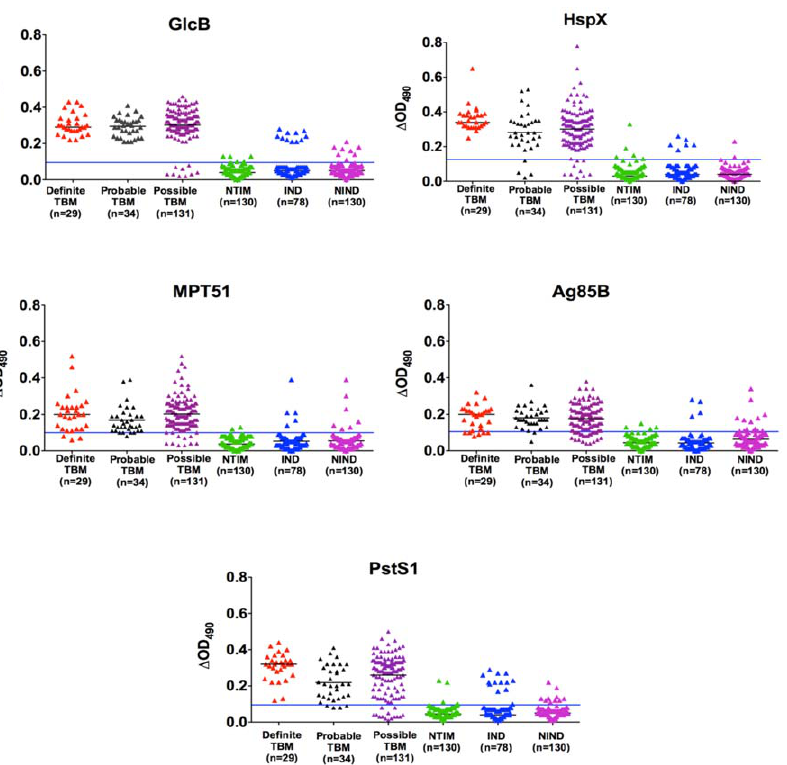
Figure 3. Antigen detection in CSF filtrates by ELISA. Scatter plots of GlcB, HspX, MPT51, Ag85B and PstS1 antigens (in 5 m l of CSF) showing D OD values. Using ROC curves generated from D OD values in CSF of ‘Definite’ TBM and NTIM group, D OD cut-off values at 0.095, 0.125, 0.1, 0.105 and 0.095 were selected for GlcB, HspX, MPT51, Ag85B and PstS1, respectively. The horizontal bar denotes the median value (black line in individual data sets) and the cut-off points (blue line across the plots).